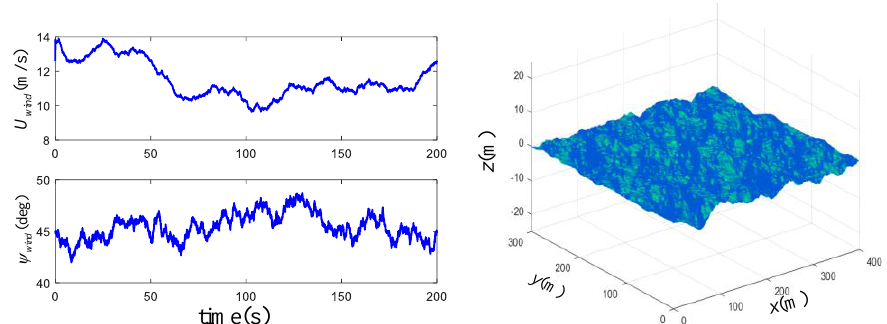
Figure 4. The simulated environment with physical-based mathematical model.